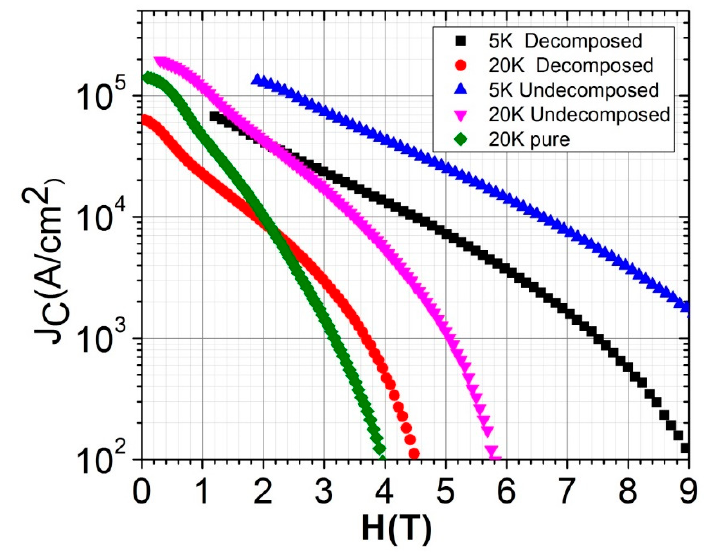
Figure 8. J C (H,T) of the CNTs and MgB 2 composite.